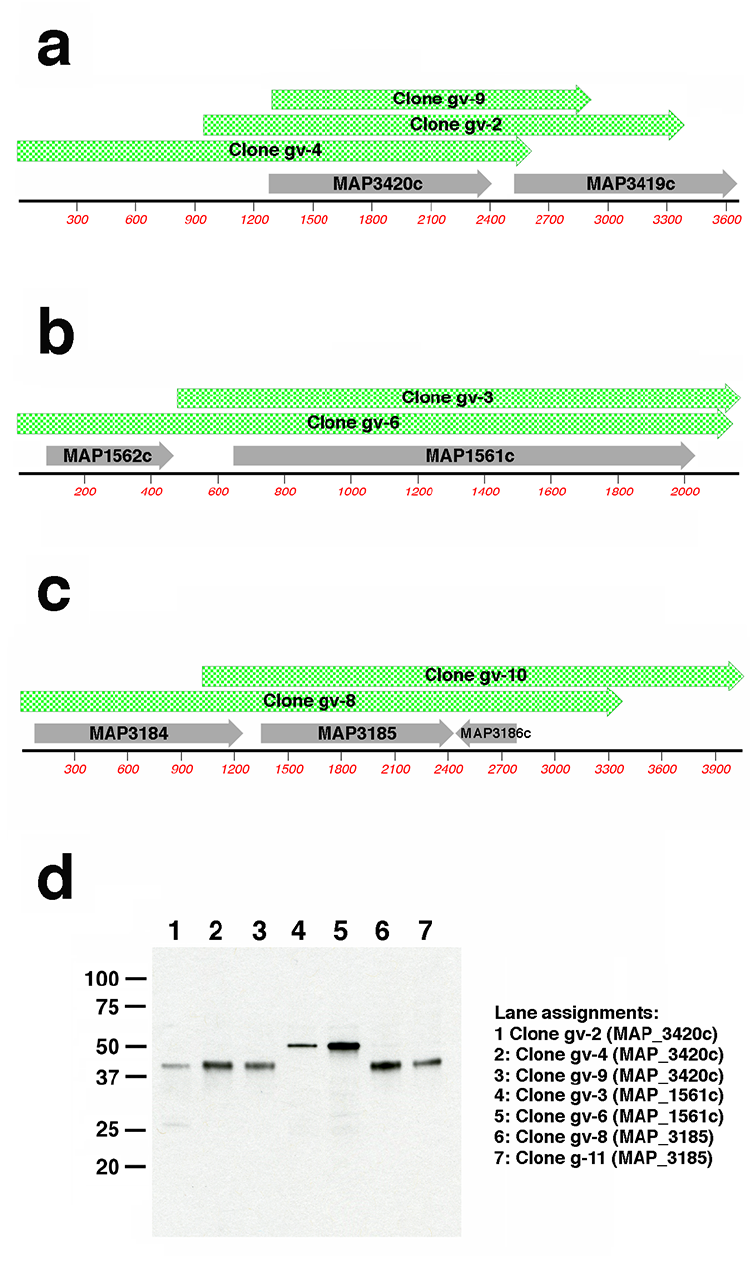
Figure 6. MAP_1561c, MAP_3185, and MAP_3420c are detected in vaccinated goats. Sequence analysis of expression library subcloned inserts shows three ( a ), two ( b ), and two ( c ) overlapping sequences aligned with the corresponding K-10 genome sequence with annotated coding sequences shown in gray. Clone insert sizes and genome coordinates are shown in Supplemental Table S1. ( d ) Immunoblot analysis of IPTG-induced lysates harboring each clone in ( a )–( c ). Pooled goat sera diluted 1:400 served as the primary antibody. Kilodalton size standards are indicated in the left margin. Lane assignments are shown right of the panel ( d ) blot. Note that only MAP_3420c is common to all inserts in ( a ), only MAP_1561c is common to both inserts in ( b ) and only MAP_3185 is common and of the correct size for aligned inserts in ( c ).